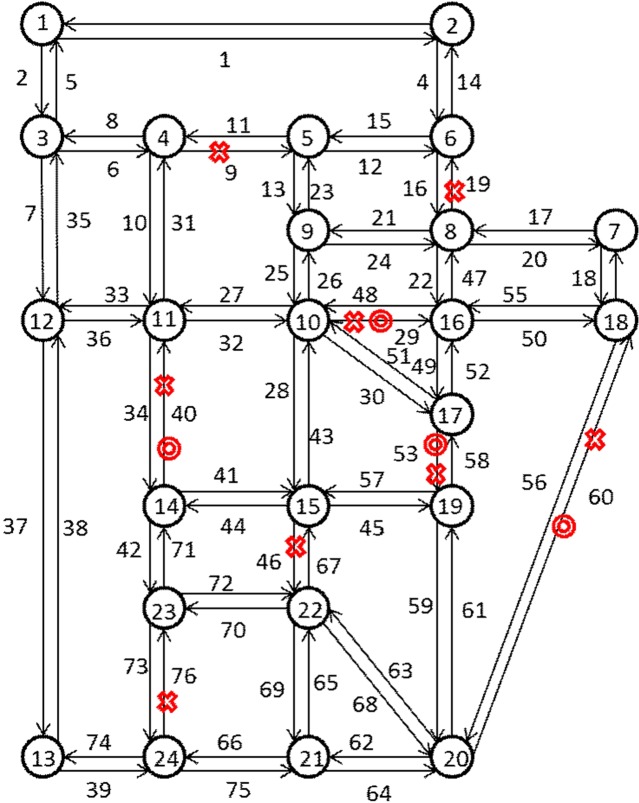
Sioux Falls network.